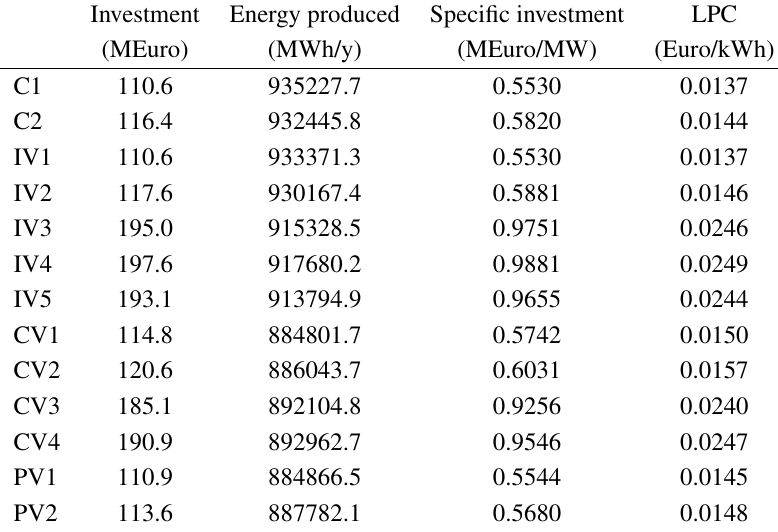
Table 5 . Investment and LPC (200 MW, 100 km, investment costs of turbines are not